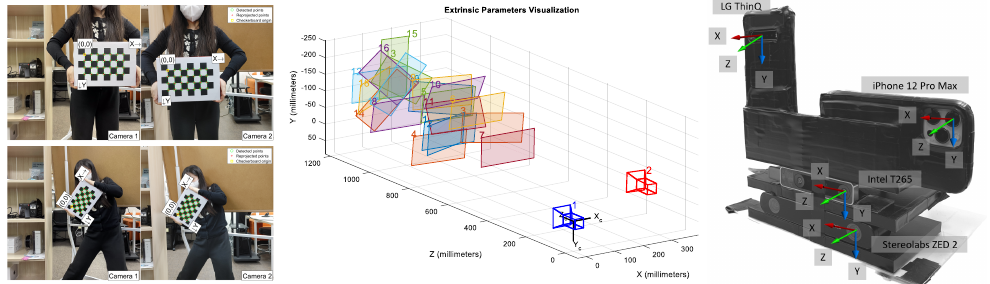
Figure 4. Intrinsic and extrinsic calibration of all cameras. We calibrated the intrinsic and extrinsic camera parameters of the four tested VIO sensors by capturing multiple views of a checkerboard. We utilized MATLAB’s built-in camera calibration toolbox and visualized the custom-built sensor rig with orientations of all four VIO